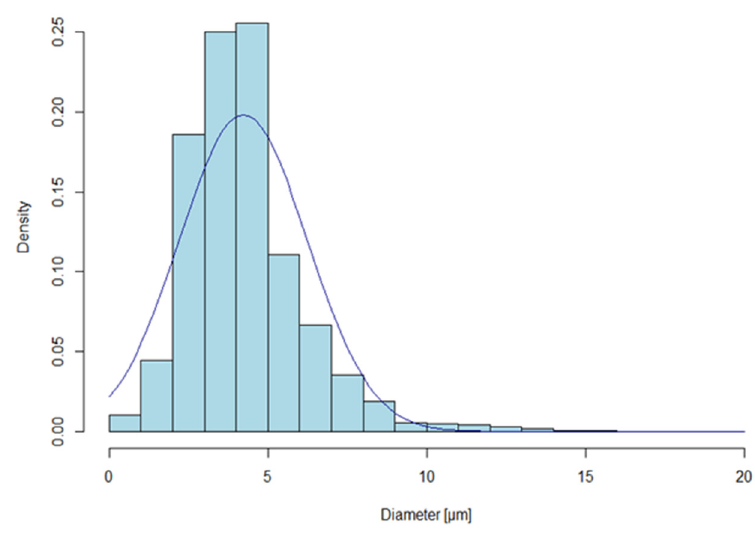
Figure 7. Mean fibre diameter distribution.